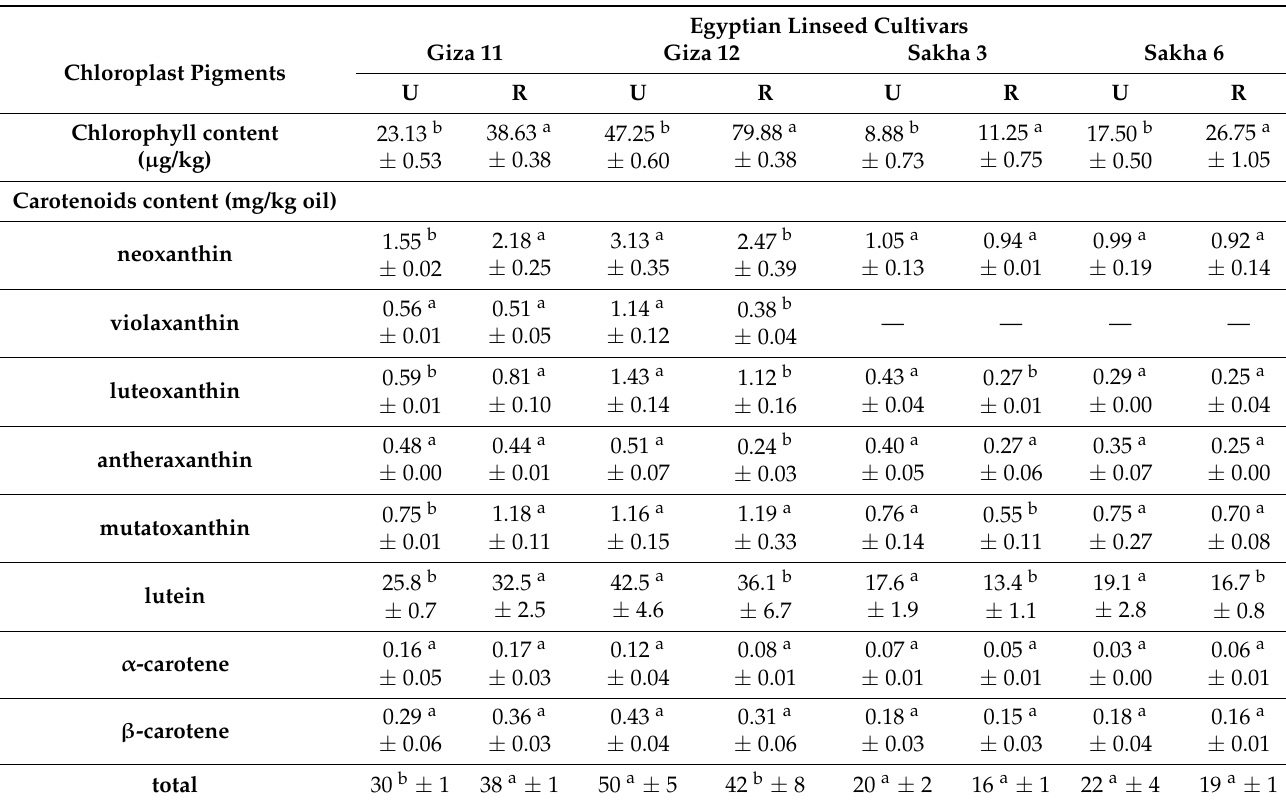
Table 3. Chloroplast pigments (chlorophyll and carotenoids) and total phenolic contents of oil extracted from four Egyptian unroasted and roasted linseed